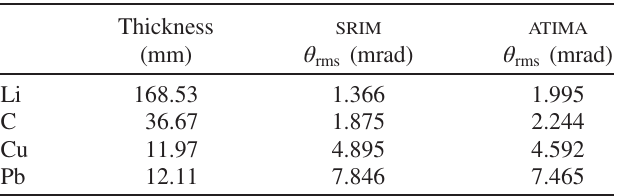
TABLE VI. Scattering angles for 1 GeV = u 238 U ions penetrat- ing through matter that causes a 20% velocity reduction, calculated by the codes SRIM and ATIMA . The exiting energy is 373 MeV = u. Statistical analysis of the SRIM data was aided by the SRIM supporting software modules [22]. Thickness SRIM ATIMA